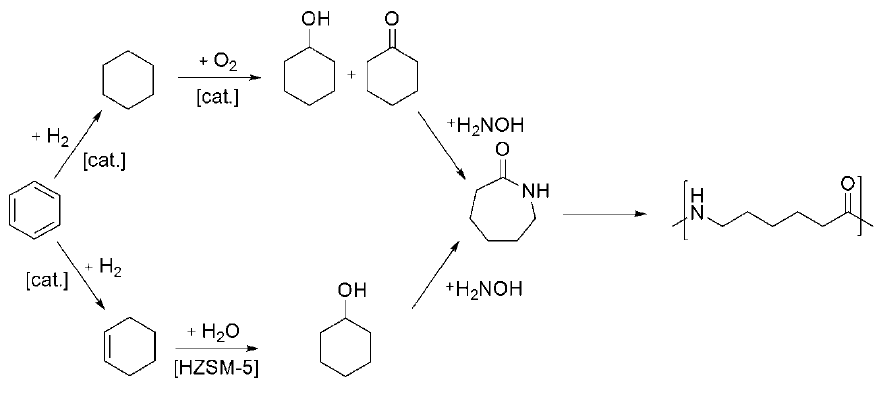
Figure 1. Two reaction pathways to form nylon 6 based on benzene.